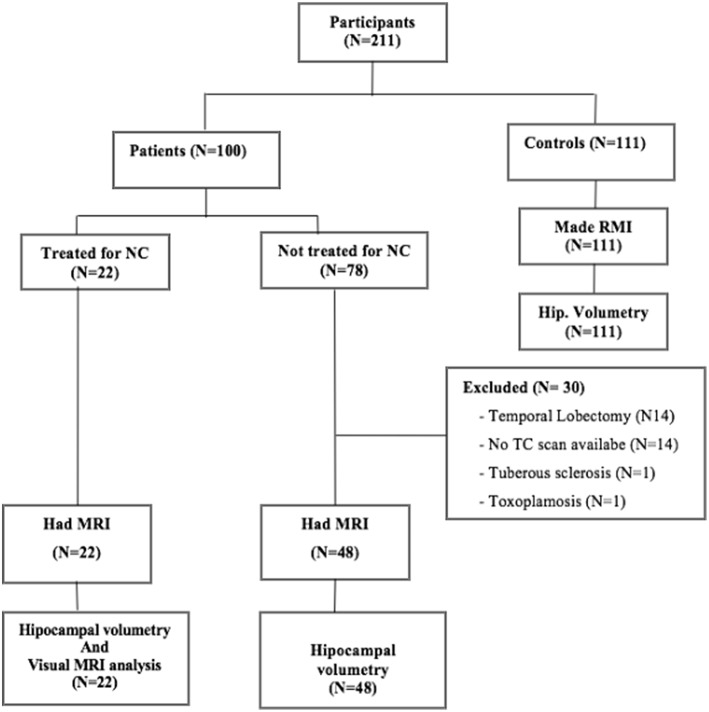
Study flowchart.